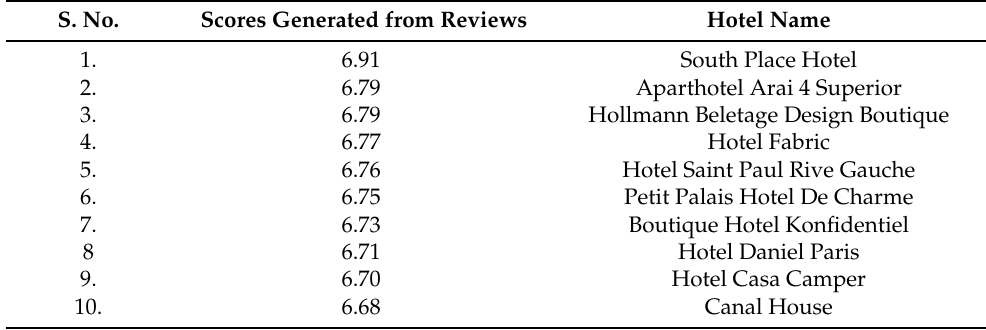
Table 9. Top-10 recommended hotels for the 1493 hotels of booking.com by analyzing reviews. S. No.